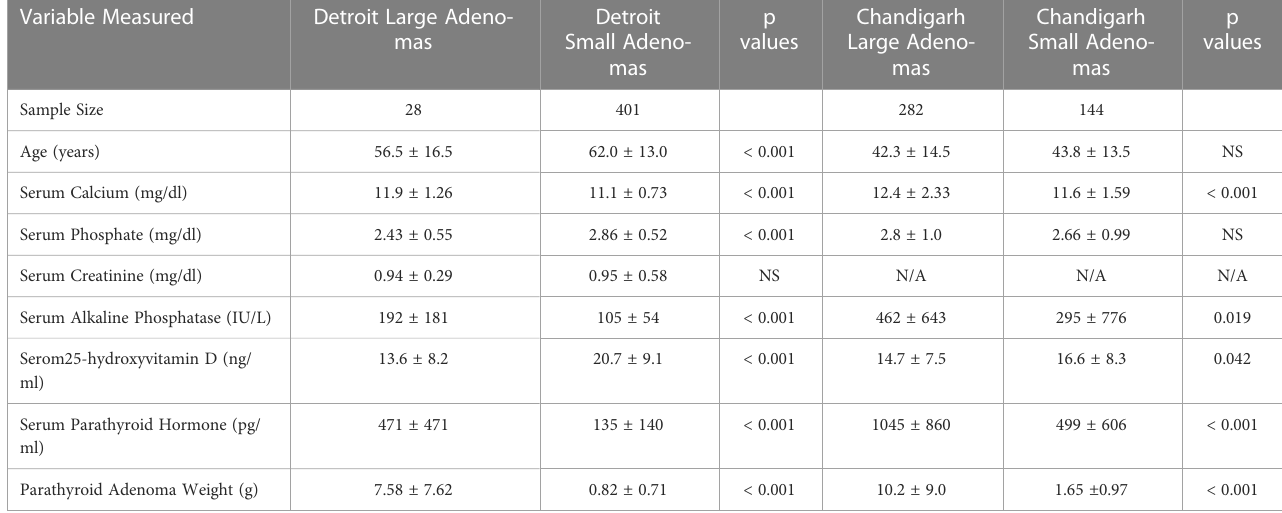
TABLE 3 Comparison of age, biochemical, and adenoma characteristics by adenoma type in the Detroit, USA and Chandigarh, India cohorts (Data shown as mean ± SD). Variable Measured